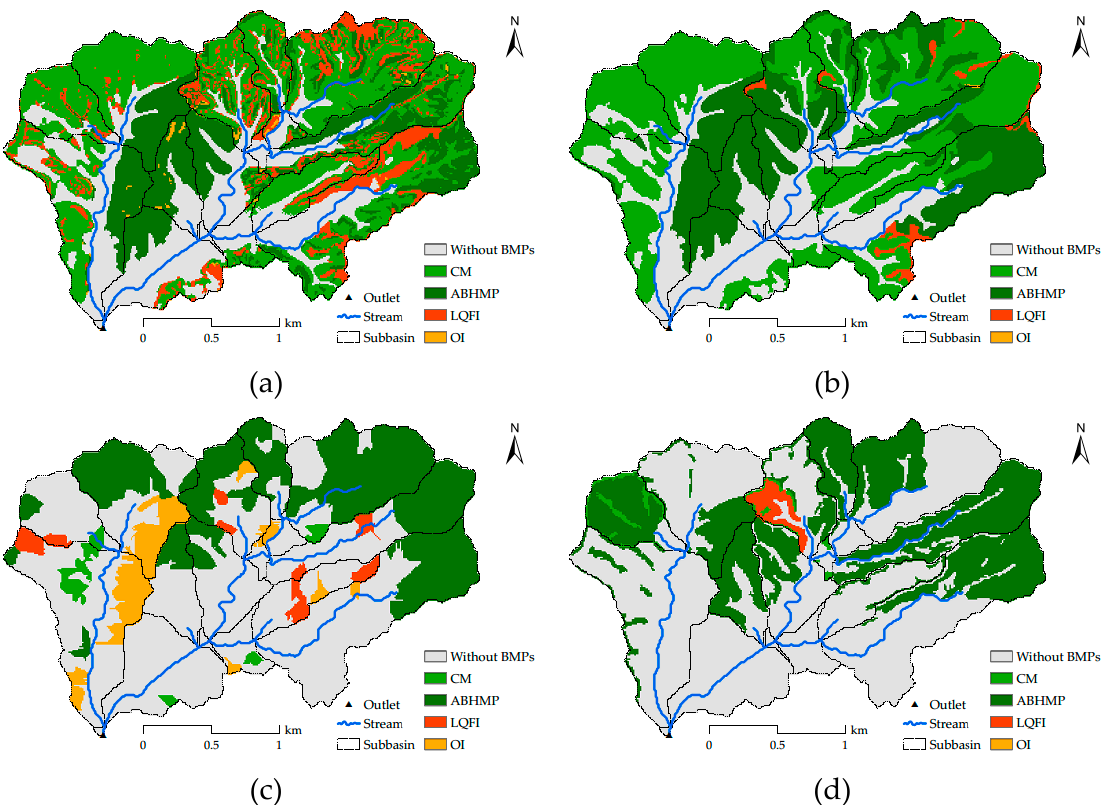
Figure 10. Comparison of the spatial distribution of selected BMP scenarios of the 100th generation from four types of BMP configuration units applied with the corresponding optimal strategies: ( a ) one HRU+SUIT scenario with a soil erosion reduction rate of 0.41 and a net cost of CNY 0.98 million; ( b ) one EXPLICIT+SUIT scenario with a soil erosion reduction rate of 0.40 and a net cost of CNY 0.97 million; ( c ) one CONNFIELD+UPDOWN scenario with a soil erosion reduction rate of 0.40 and a net cost of CNY 1.08 million; and ( d ) one SLPPOS+HILLSLP scenario with a soil erosion reduction rate of 0.40 and a net cost of CNY 0.78 million.